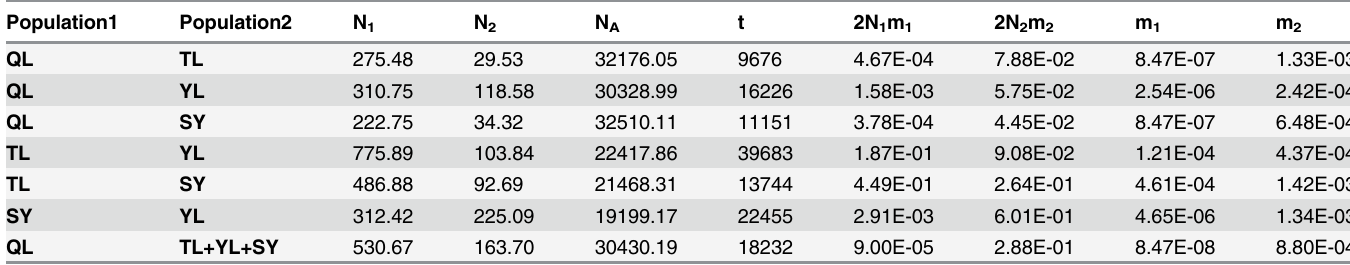
Table 5. Estimated population genetics parameters of the R . apiculata populations in Hainan,